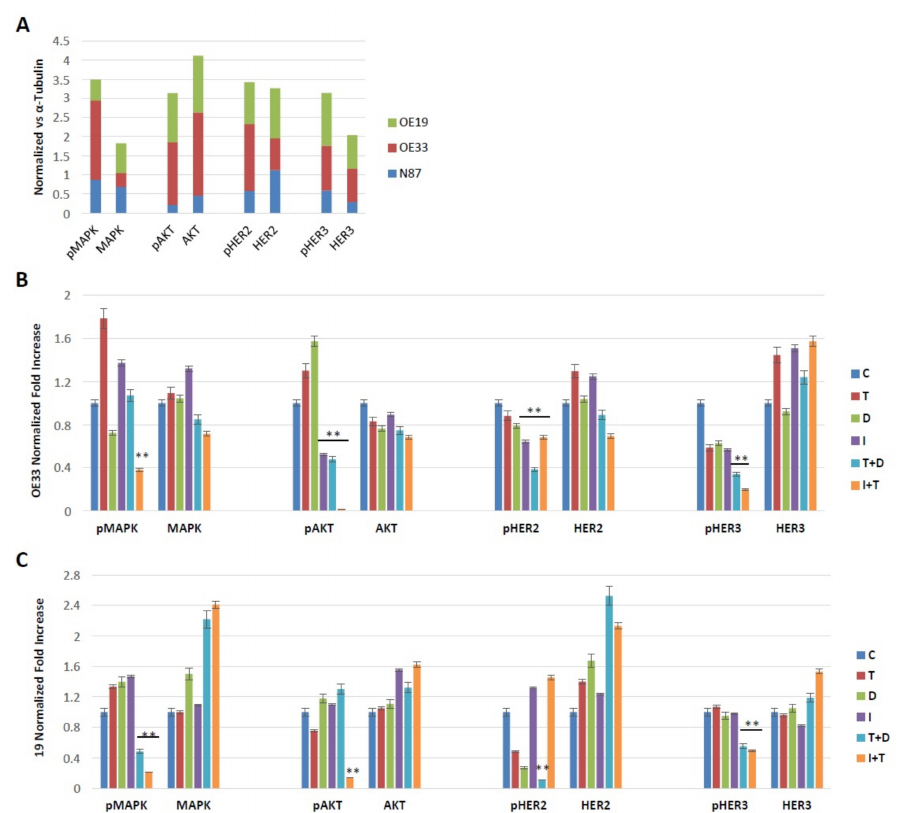
Figure 6. Graphic representation of western blotting data (shown in Figure 5) by densitometric analysis and relative normalization of each band compared with α Tubulin (C: untreated control, T: Trastuzumab, D: Duligotuzumab, I: Ipatasertib, Trastuzumab with Duligotuzumab, T+D; Ipatasertib with Trastuzumab, I+T). Asterisks indicate statistical significance (** p ≤